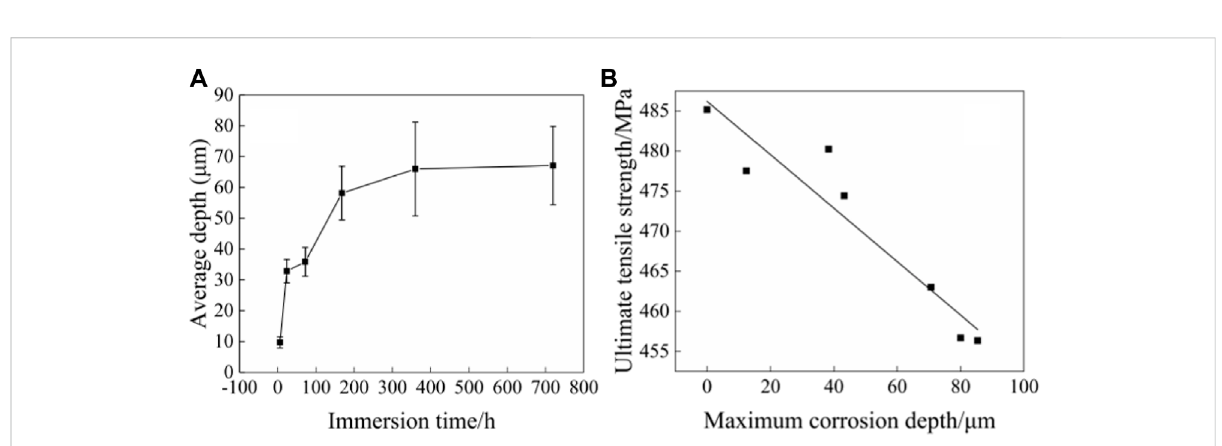
FIGURE 10 Correlation between corrosion depth and tensile strength of 2060-T4 Al-Li alloy immersed for 6, 24, 72, 168, 360 and 720 h in 3.5wt% NaCl solution. (A) Corrosion depth vs immersion time, (B) ultimate tensile strength vs corrosion depth.